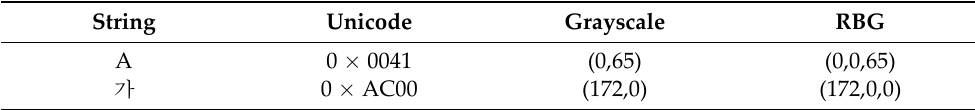
Table 7. Unicode and coordinate values of